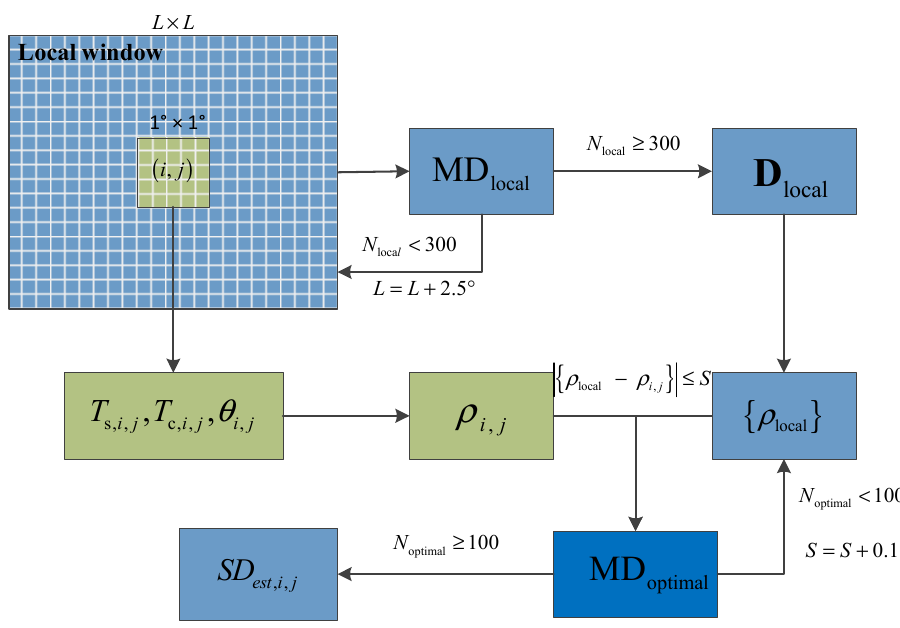
Figure 4. Schematic diagram of the error standard deviation estimation SD est using the optimal matched datasets ( MD optimal ) for visible and infrared radiometer (VIRR) surface sea temperature (SST) products. T s , i , j , T c , i , j , θ i , j , and ρ i , j separately stand for the original VIRR SST, climatology SST, view zenith angle, and estimated standard deviation in the position of SST matrix ( i , j ), respectively.